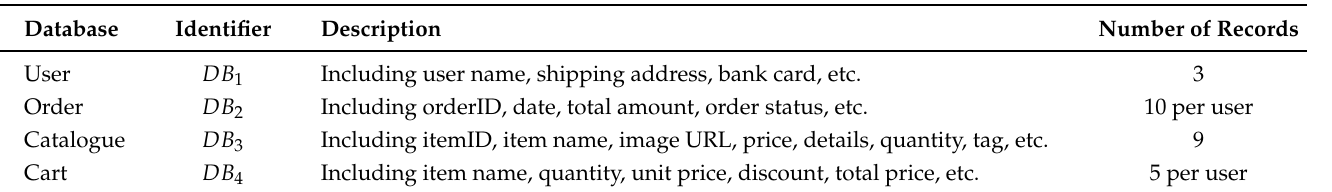
Table 6. Descriptions and settings of databases in Sock-Shop.